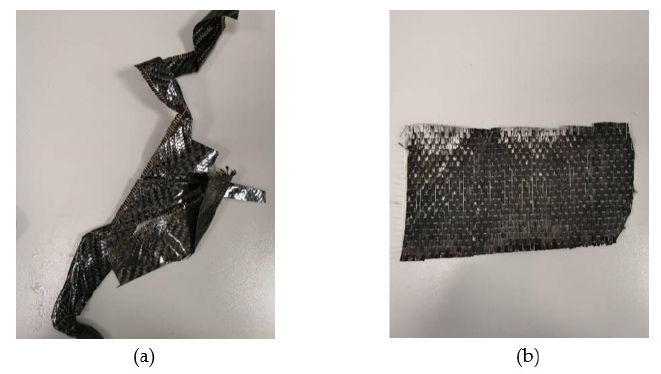
Figure 4. The original shape of the samples ( a ) CFRP, ( b ) CF.